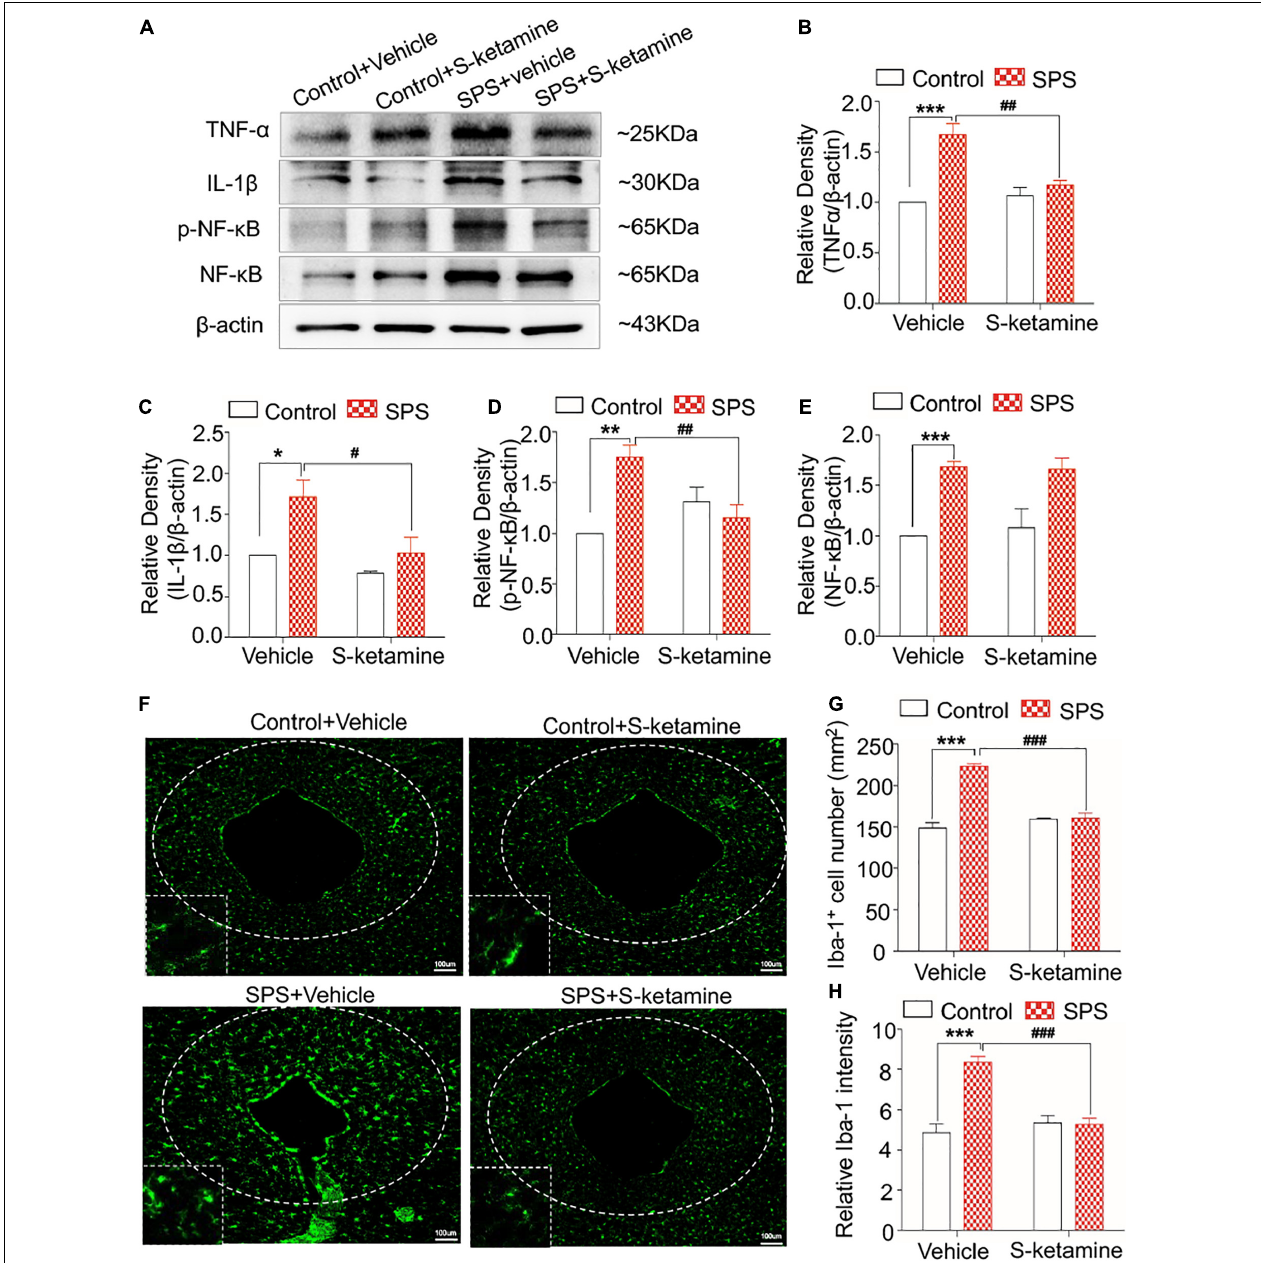
FIGURE 6 | S-ketamine alleviates microglial activation and downregulates pro-inflammatory cytokines in the periaqueductal gray. Rats were randomly assigned into control + vehicle group, SPS + vehicle group, control + S-ketamine 5 mg/kg group and SPS + S-ketamine 5 mg/kg group. n = 3 per group. (A) Protein levels of TNF- α , IL-1 β , p-NF- κ B, and NF- κ B in the PAG. Relative intensity of TNF- α (B) , IL-1 β (C) , p-NF- κ B (D) , and NF- κ B (E) in the PAG. (F) Immunofluorescence staining of Iba-1 in the dorsal striatum. (G) The number of Iba-1-positive stained cells in the PAG. (H) Relative intensity of Iba-1-positive stained cells in the PAG. * P < 0.05, ** P < 0.01, and *** P < 0.001, control + vehicle group vs. SPS + vehicle group; # P < 0.05, ## P < 0.01, and ### P < 0.001, SPS + S-ketamine 5 mg/kg group vs. SPS + vehicle